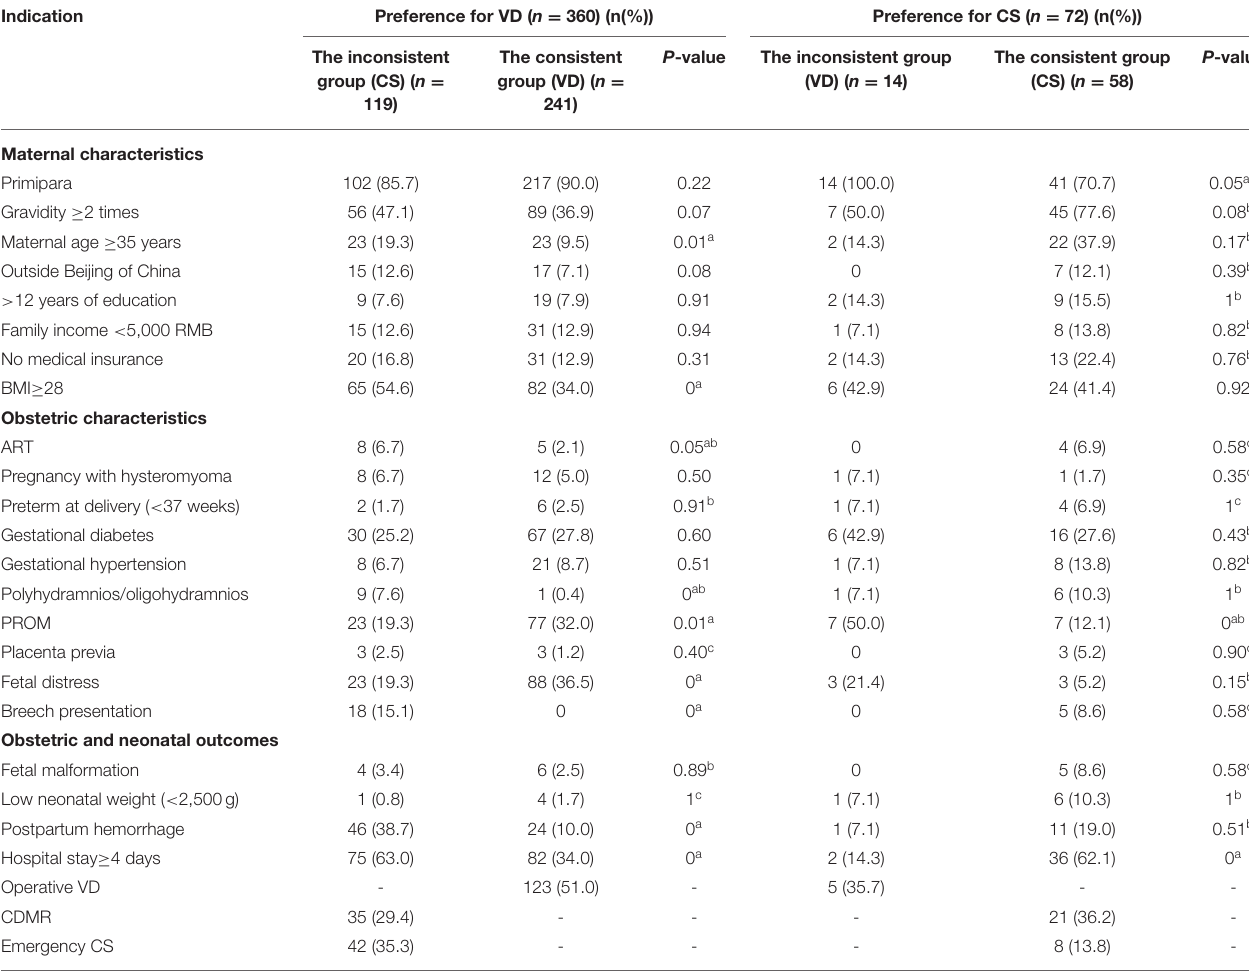
TABLE 2 | Maternal characteristics, obstetric characteristics, obstetric and neonatal outcomes stratified by preference for delivery mode and the